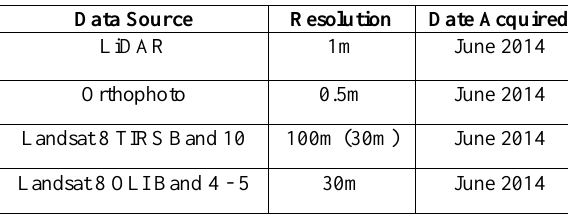
Table 1. Summary of data sources, spatial resolution,